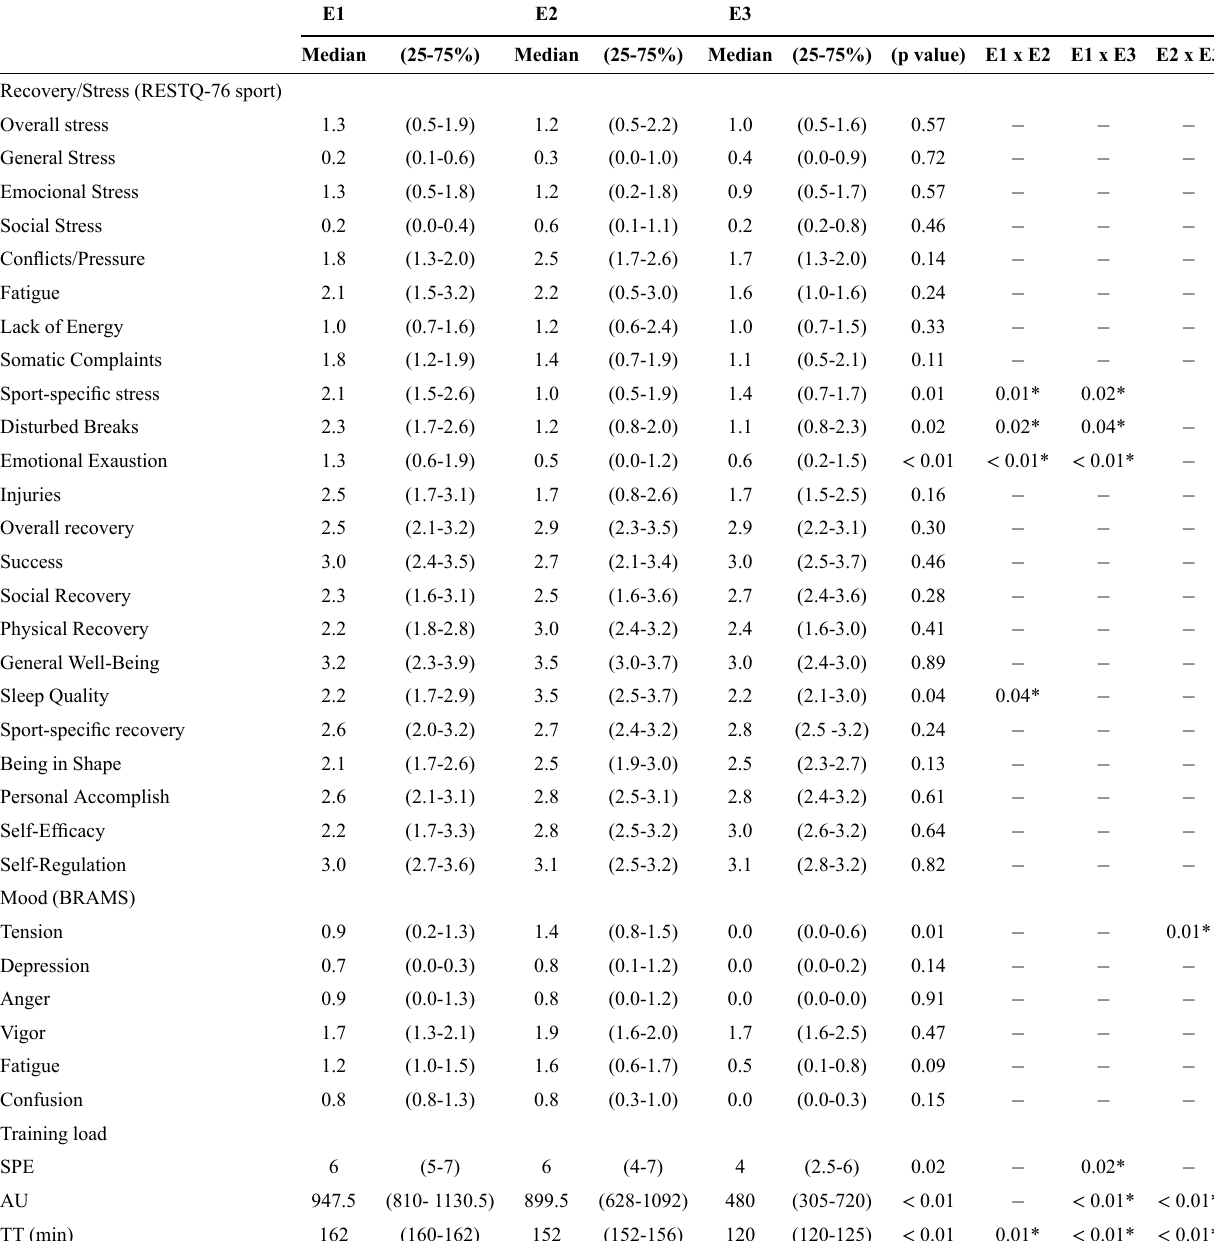
Table 2 - Comparison between the moments of assessment of psychological variables and training